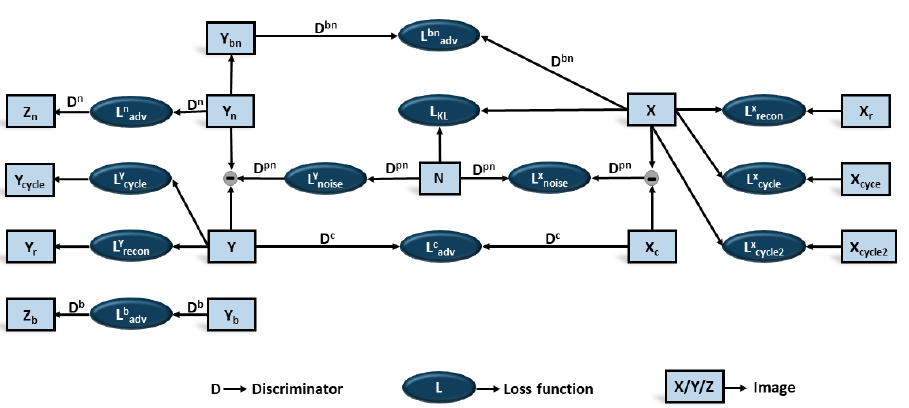
Figure 3. Diagramillustrating the inputs and outputs of loss functions. The inputs include X : original images, Y : clean images, Z : real blurred/noisy